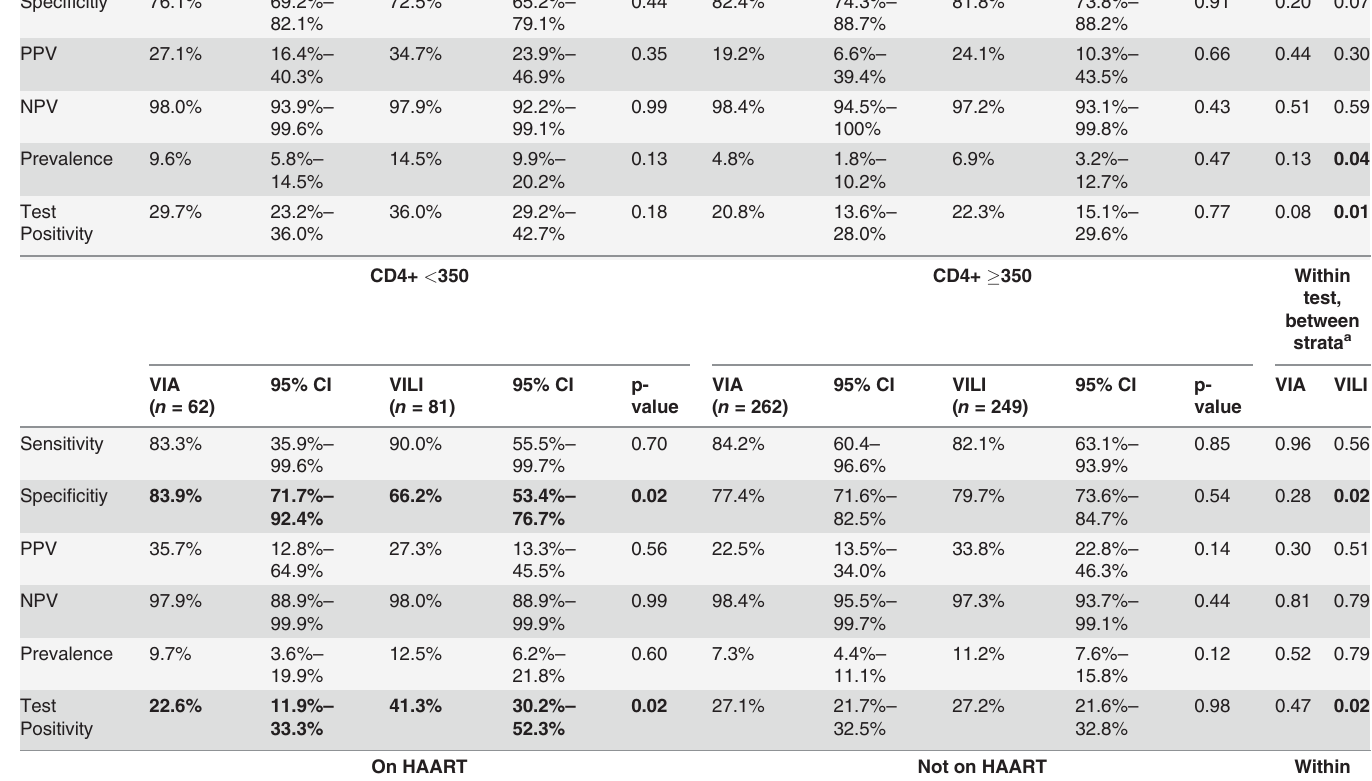
test, between strata